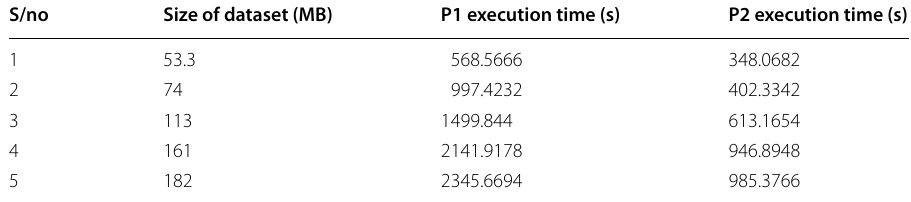
Table 1 ConTra’s processing speed on different servers for different dataset